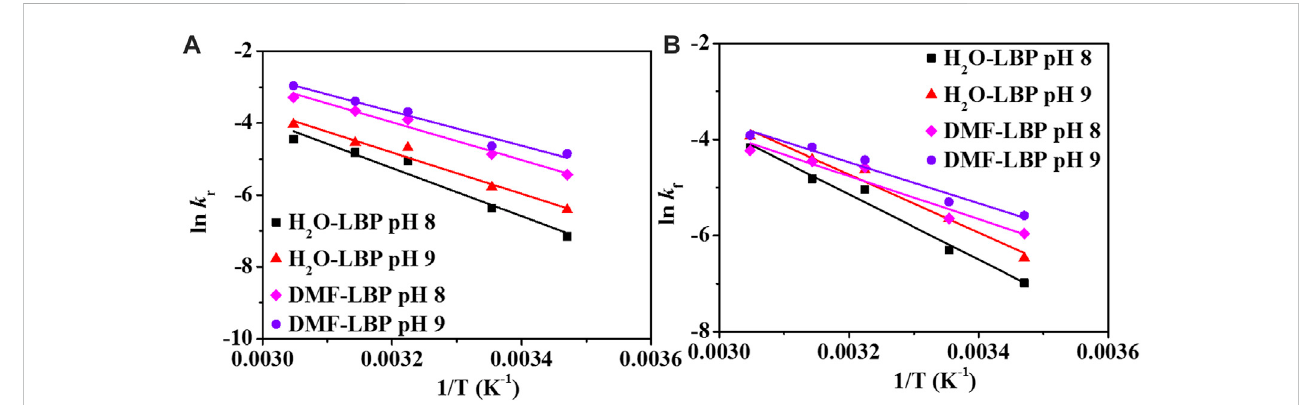
FIGURE 4 Plots ln k r (A) and ln k f (B) vs. 1/T at pH 8 and 9. k r : reaction rate constant calculated based on the UV absorbance; k f : reaction rate constant calculated based on